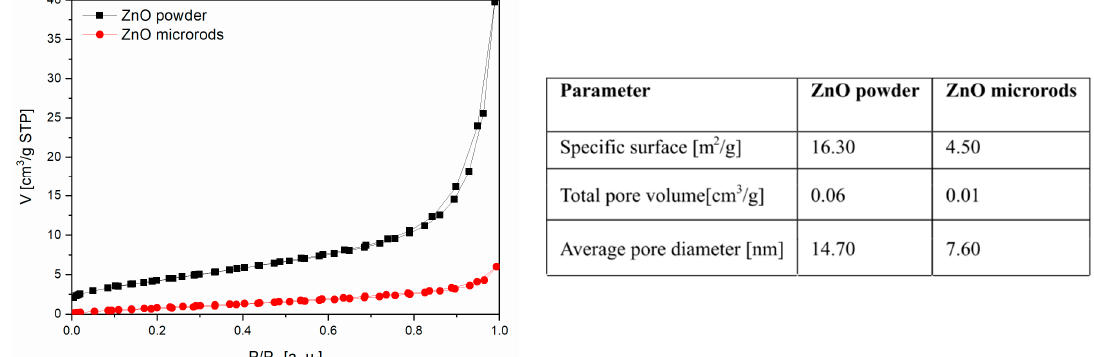
Figure 4. Isotherms of N 2 adsorption / desorption and Brunauer–Emmett–Teller (BET) analysis results of the samples.